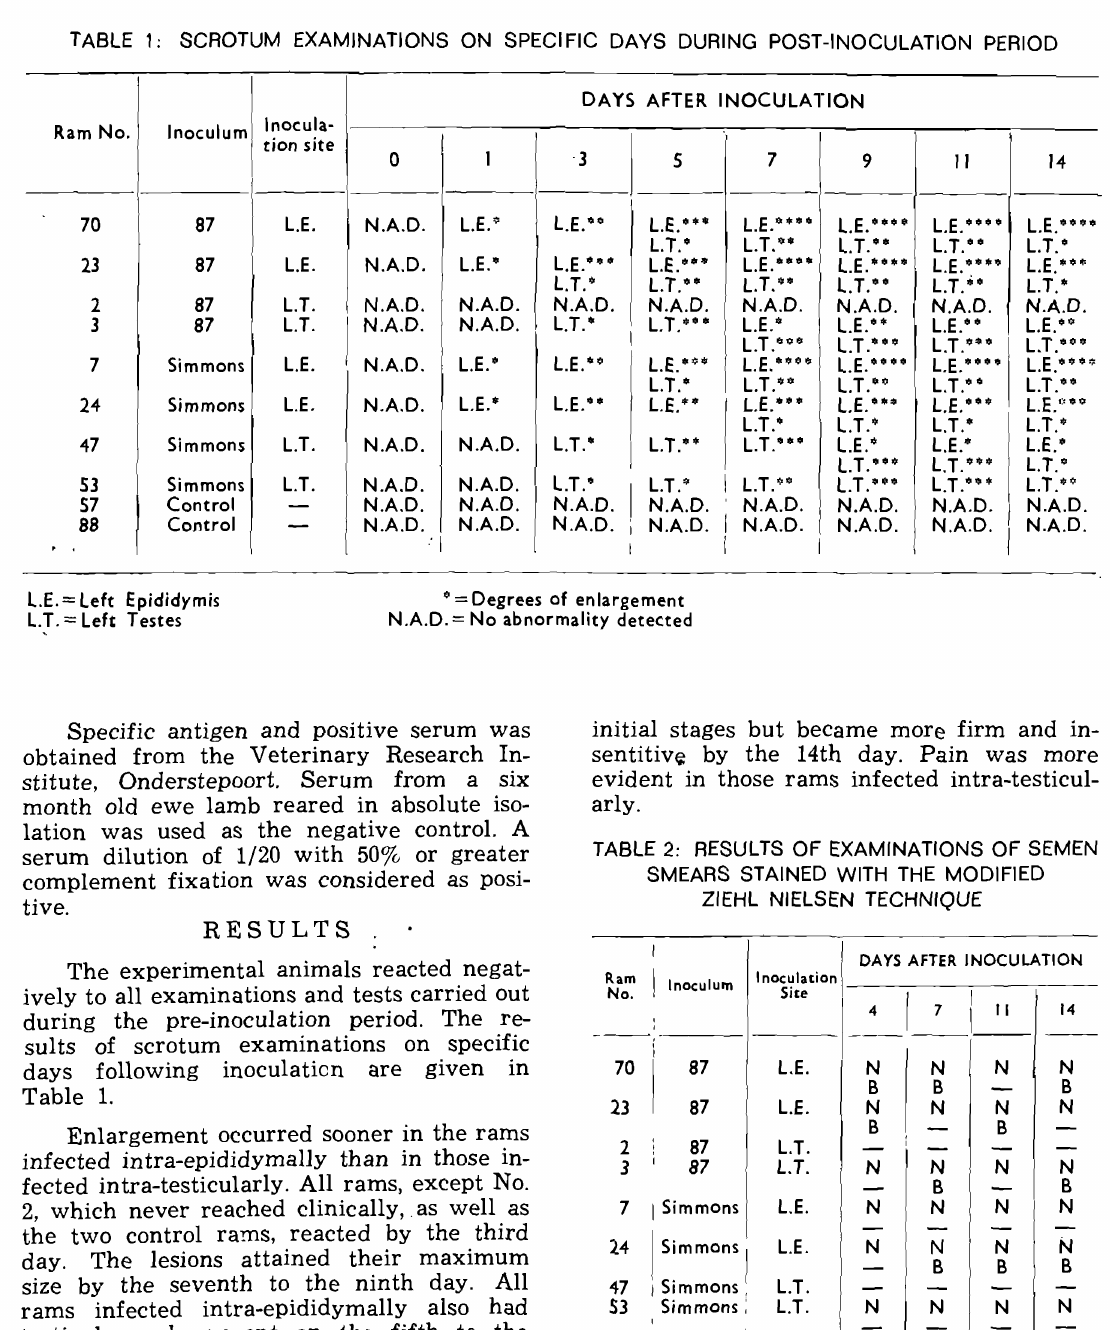
TABLE 1: SCROTUM EXAMINATIONS ON SPECIFIC DAYS DURING POST-INOCULATION PERIOD Ram No.